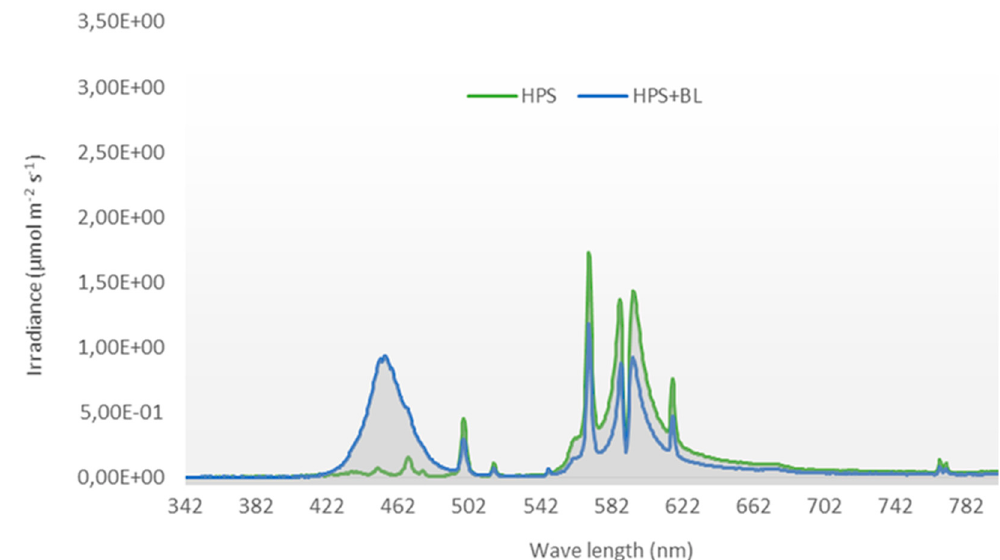
Figure 1. Light spectra of the lamps used in the study of Norway spruce and subalpine fir: Green line = 5% blue light (BL): High pressure sodium (HPS) lamps (Osram NAV T-400W). Blue line = 30% BL: HPS + blue light-emitting diodes (Philips GreenPower LED module HF Blue, Philips, Eindhoven, The Netherlands). Table 1. Description of the light quality treatments in the two chambers used in the study of Norway spruce and subalpine fir. The main light source was high-pressure sodium (HPS) lamps (5% blue light (BL)) and the 30% BL treatment (HPS + BL) was supplemented with blue LEDs. Blue Light